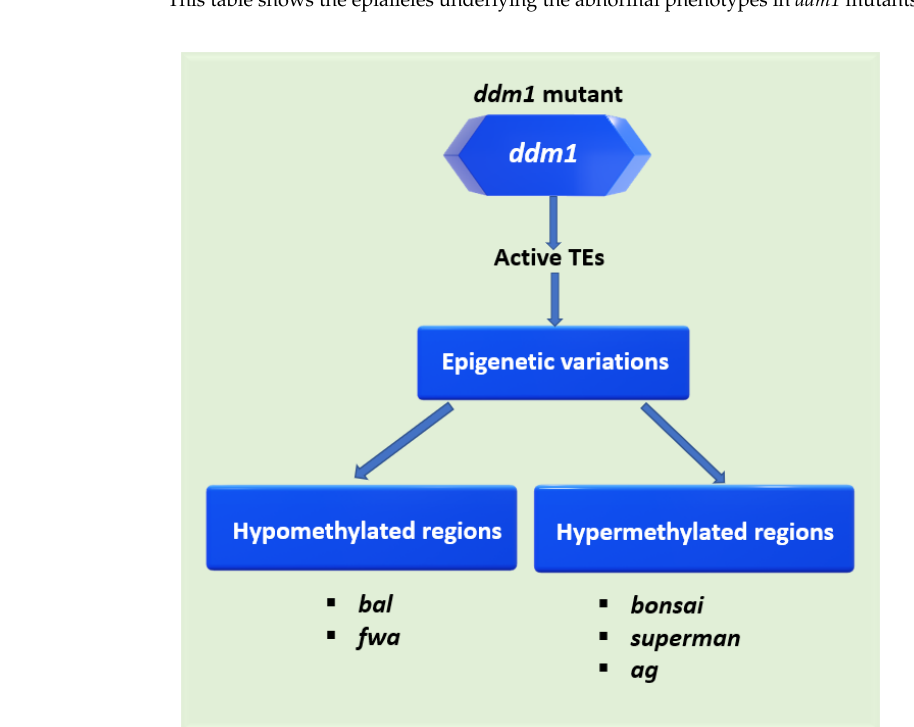
Table 1. Epialleles induced by DDM1 null